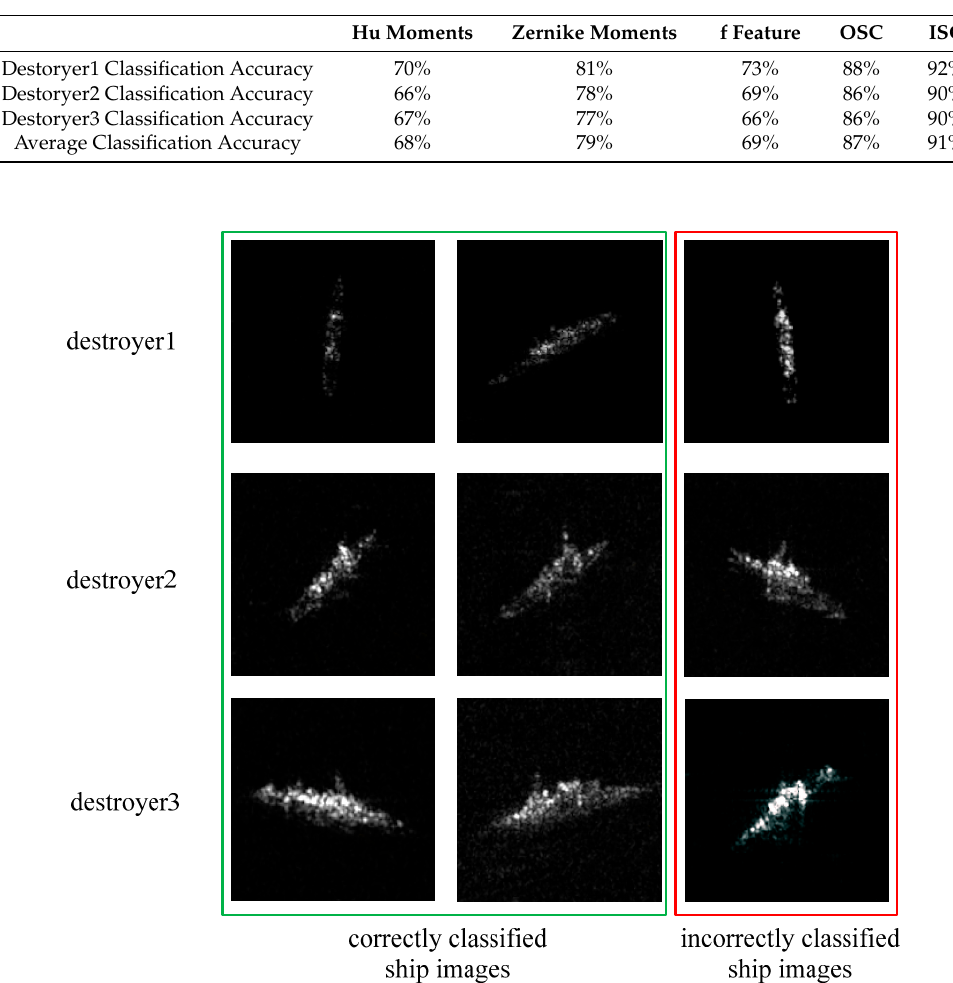
Figure 8. The correctly and incorrectly classified ship images of OSC for three types of destroyers.